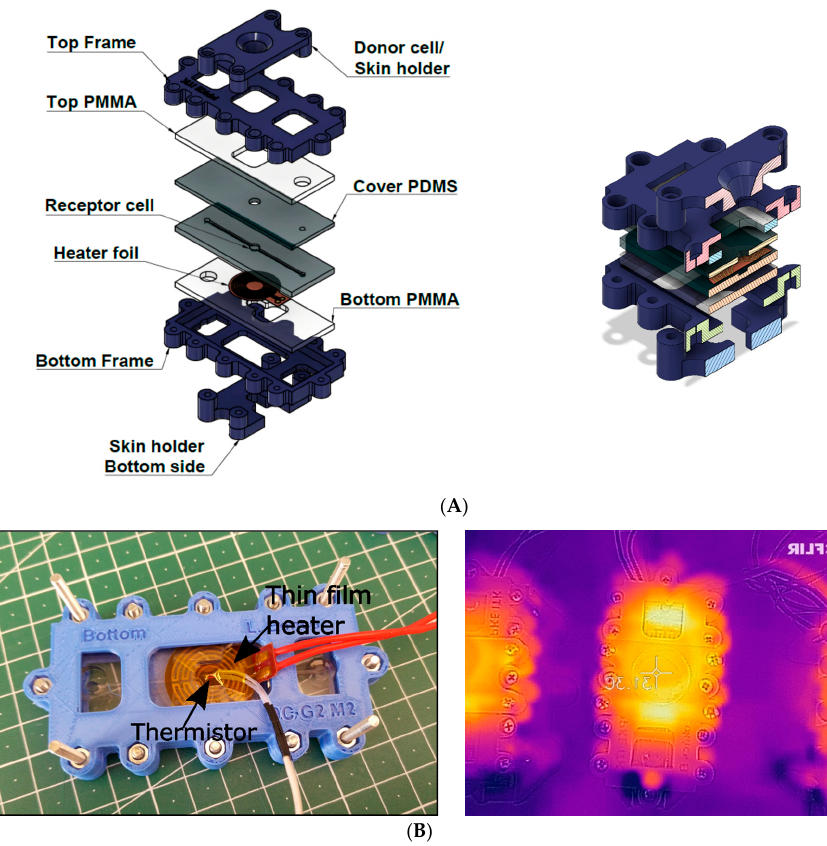
Figure 2. Exploded schematic view of the Microfluidic Diffusion Chamber (MDC) ( A ). Left: Layer-by-layer view of the device. Right: Cross sectional view of the device. Temperature-controlled skin-on-a chip device (MDC) ( B ). Left: The bottom side of the chip with the circular thin film heater and thermistor. Right: The temperature control measurement with a thermo-camera.